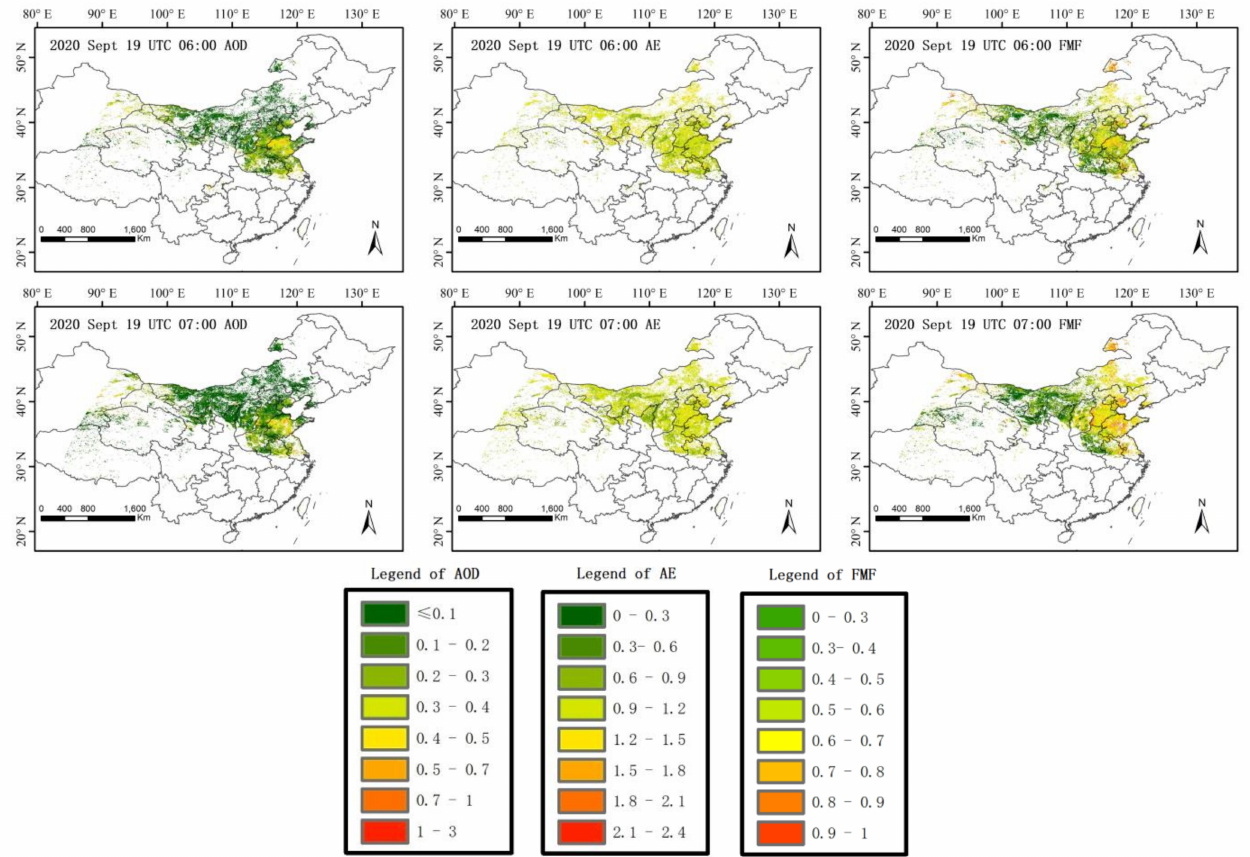
Figure 6. The NNAeroG retrieved hourly AOD, AE and FMF using Himawri-8/AHI data from 02:00 to 07:00 (UTC) on 19 September 2020 over land in China. The left column is AOD; the middle column is AE, and the right column is